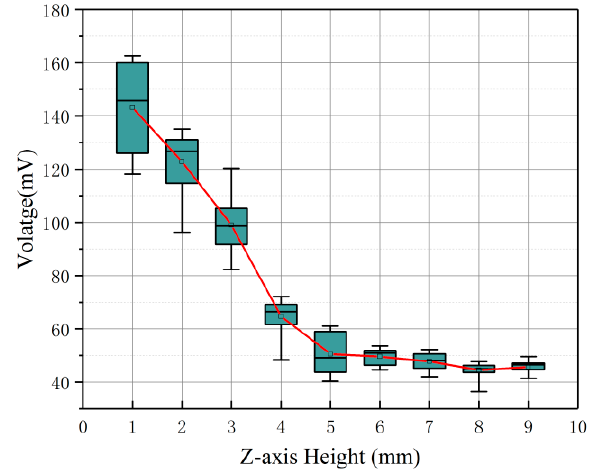
Figure 12. Variation in the output voltage with the z-axis height